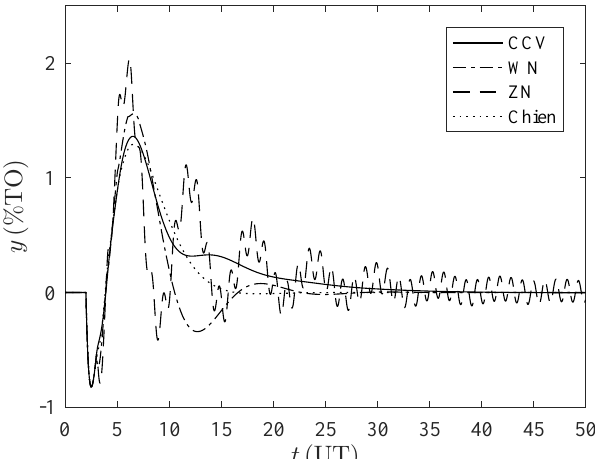
Figure A4. Time response set-point tracking for the set P 2 . %TO: percentage of transmitter output, UT: units of time.